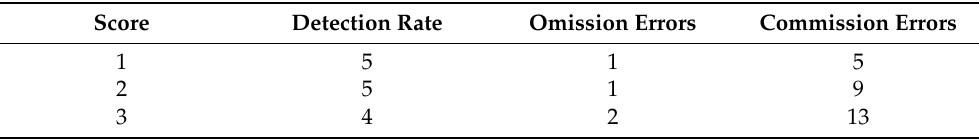
Table 4. Detection rate, errors of omission and commission errors for stream gorges with different score values compared to ground reference stream gorge data.